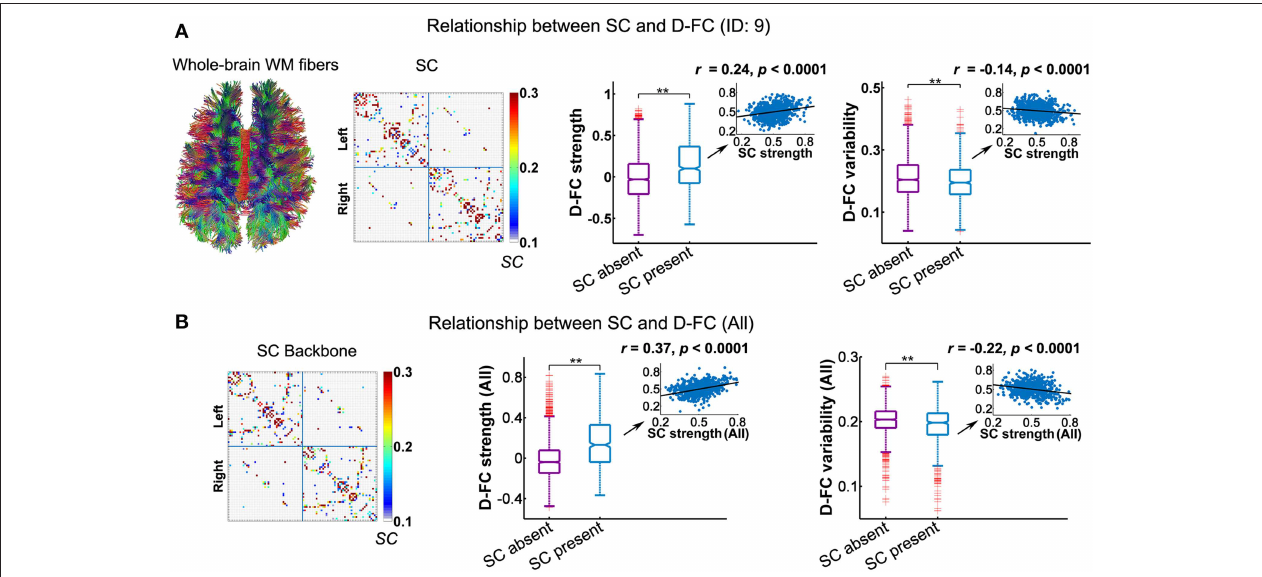
FIGURE 4 | Relationship between the D-FC and structural connectivity (SC) networks for one representative participant (ID: 9) (A) and for the whole group (B). (A) Schematic of whole-brain white matter (WM) fibers and SC matrix (left), and the differences in D-FC strength and variability between region pairs with direct SC (SC present) or not (SC absent) (right). The WM fibers were estimated from whole-brain tractography, and SC strength was represented by the normalized streamline number. (B) The SC backbone network across all participants (left) and differences in D-FC strength and variability between region pairs with or without direct SC (right). Group-level analyses were performed on the 10 participants that possessed both R-fMRI and DTI data, given that the DTI data of one participant (ID: 1) were not available. In (A,B) , significant differences in D-FC strength/variability between two groups were tested using permutation tests ( ** p < 0 . 0001 , 10,000 permutations). Scatter plots (insets) show the correlation between D-FC strength/variability and SC strength, confined to the regional pairs with direct SC. Prior to the correlation analysis, all of these measures were resampled into a Gaussian distribution, with mean ± std = 0.5 ± 0.1. D-FC, dynamic functional connectivity.